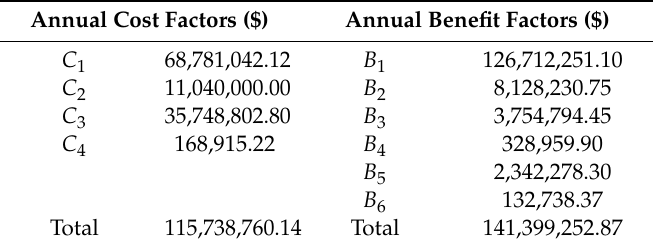
Table 8. The annual value of cost and benefit